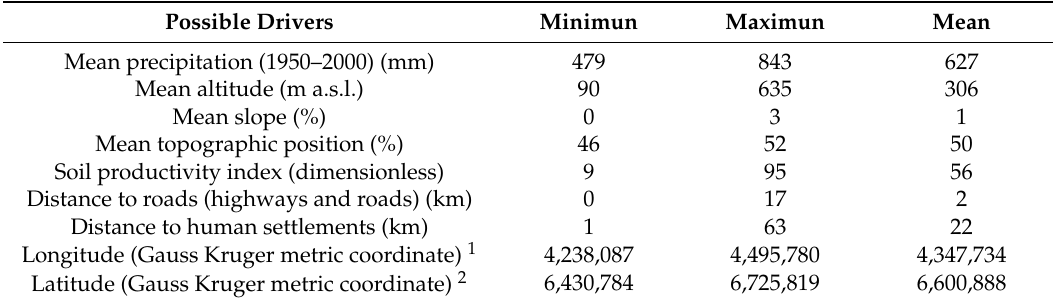
Table 2. Descriptive statistics of the possible driving forces for the 81 circles. Possible